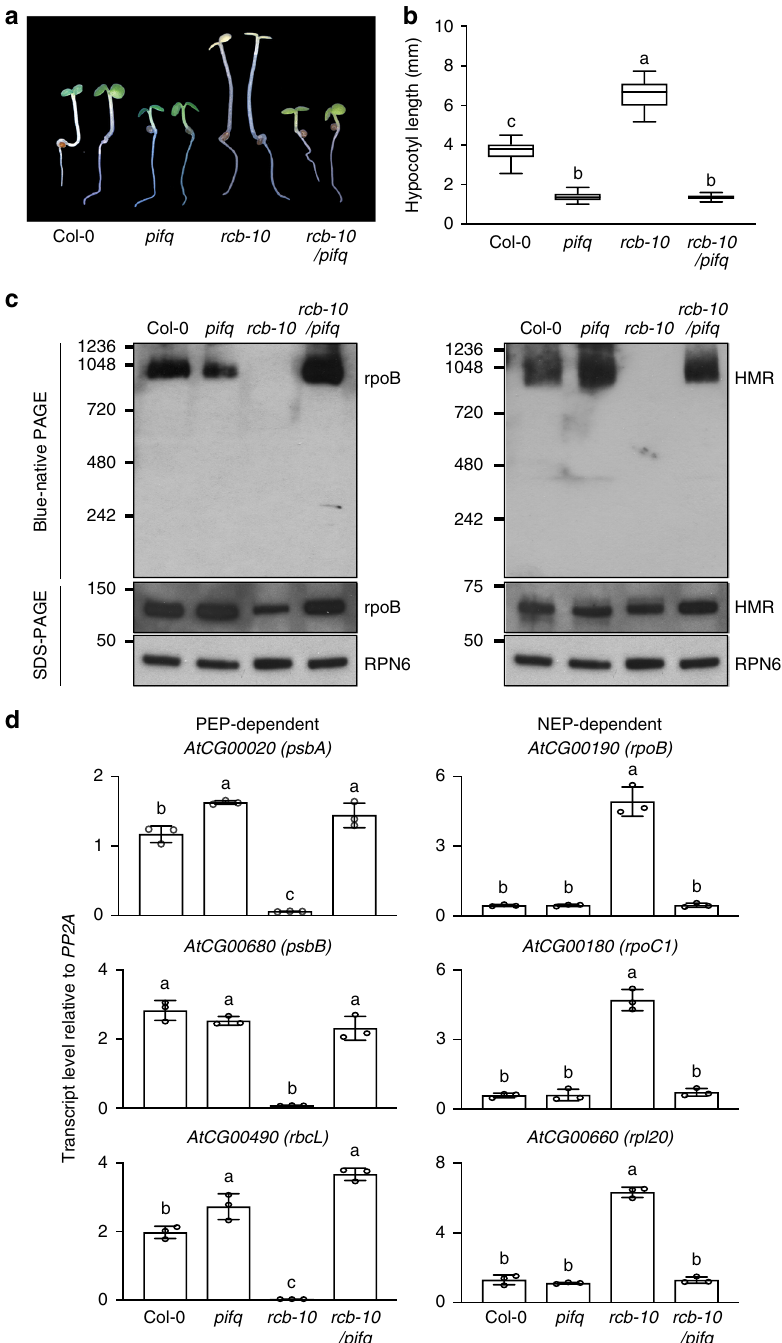
Fig. 6 Removal of four PIF s in rcb-10 rescued its tall and albino phenotypes. a Representative images of 4-d-old Col-0, pifq , rcb-10 , and rcb-10/pifq seedlings grown in 10 μ mol m − 2 s − 1 R light. b Box-and-whisker plots of hypocotyl length measurements for the seedlings shown in ( a ). The boxes represent from the 25th to the 75th percentiles, and the bars equal the median values. Different letters denote statistically signi fi cant differences in hypocotyl length (ANOVA, Tukey ’ s HSD, p ≤ 0.001). c Immunoblots showing the level of the PEP complex (blue-native PAGE), as well as the total amount of rpoB and HMR (SDS- PAGE) in 4-d-old Col-0, pifq , rcb-10 , and rcb-10/pifq seedlings grown in 10 μ mol m − 2 s − 1 R light. RPN6 was used as a loading control. d , qRT-PCR analyses of the transcript levels of representative PEP- and NEP-dependent genes in 4-d-old Col-0, pifq , rcb-10 , and rcb-10/pifq seedlings grown in 10 μ mol m − 2 s − 1 R light. Different letters denote statistically signi fi cant differences in hypocotyl length (ANOVA, Tukey ’ s HSD, p ≤ 0.001). Error bars represent SD of three biological replicates. The source data underlying the hypocotyl measurements in ( b ), the immunoblots in ( c ), and the qRT-PCR analysis in ( d ) are provided in the Source Data fi